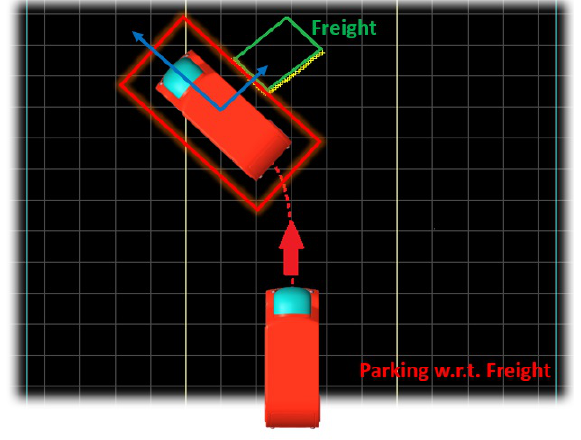
Figure 3. Parking w.r.t